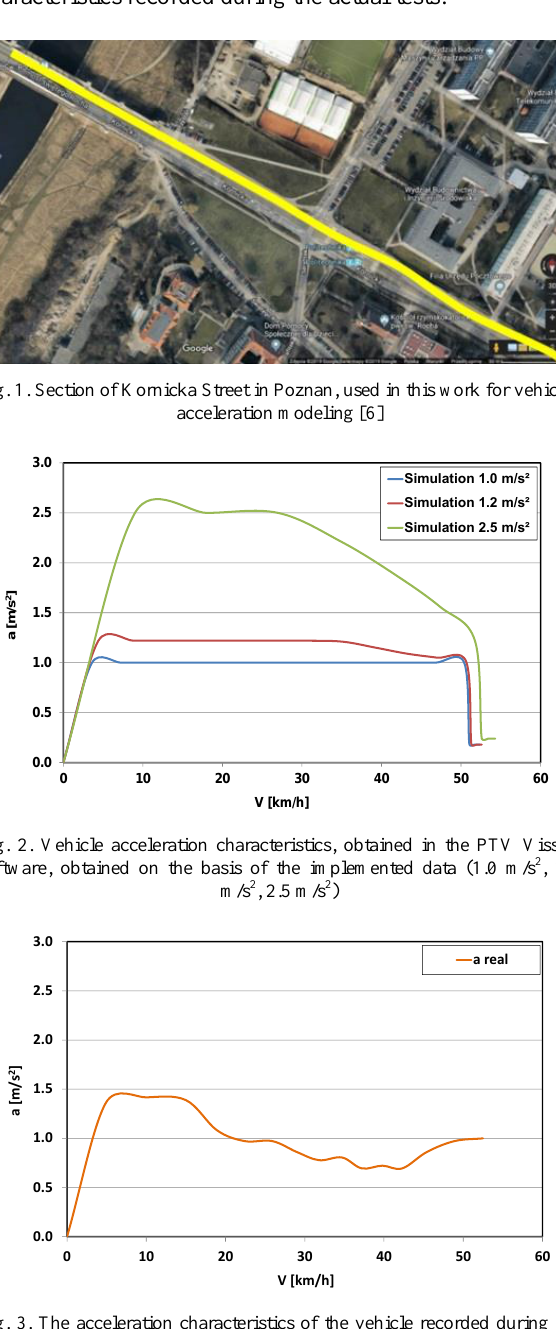
Fig. 3. The acceleration characteristics of the vehicle recorded during the actual acceleration test